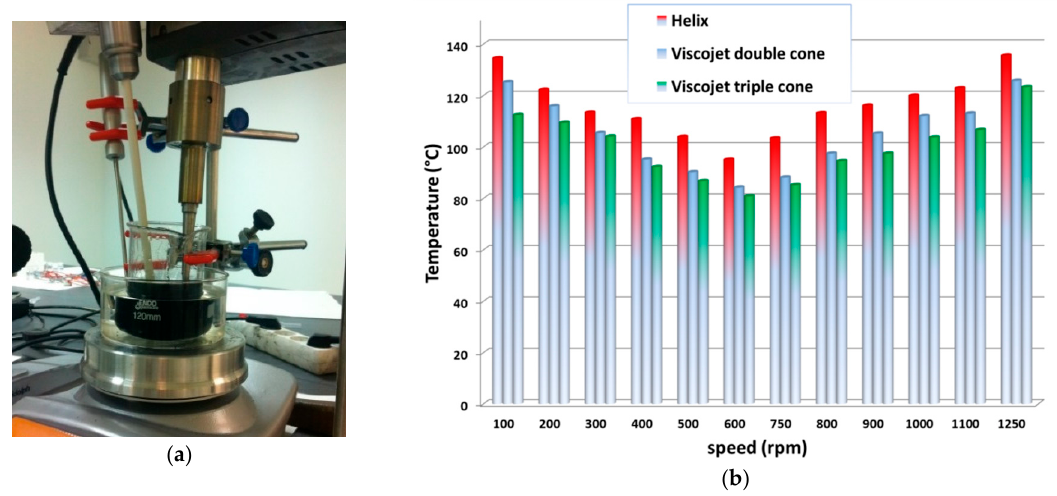
Figure 9. ( a ) Ultrasound-assisted with high-speed mechanical agitation set up; ( b ) effect of the applied agitation speed of three different probes on the temperature: (1) helix, (2) viscoject double cone, (3) viscoject triple cone.